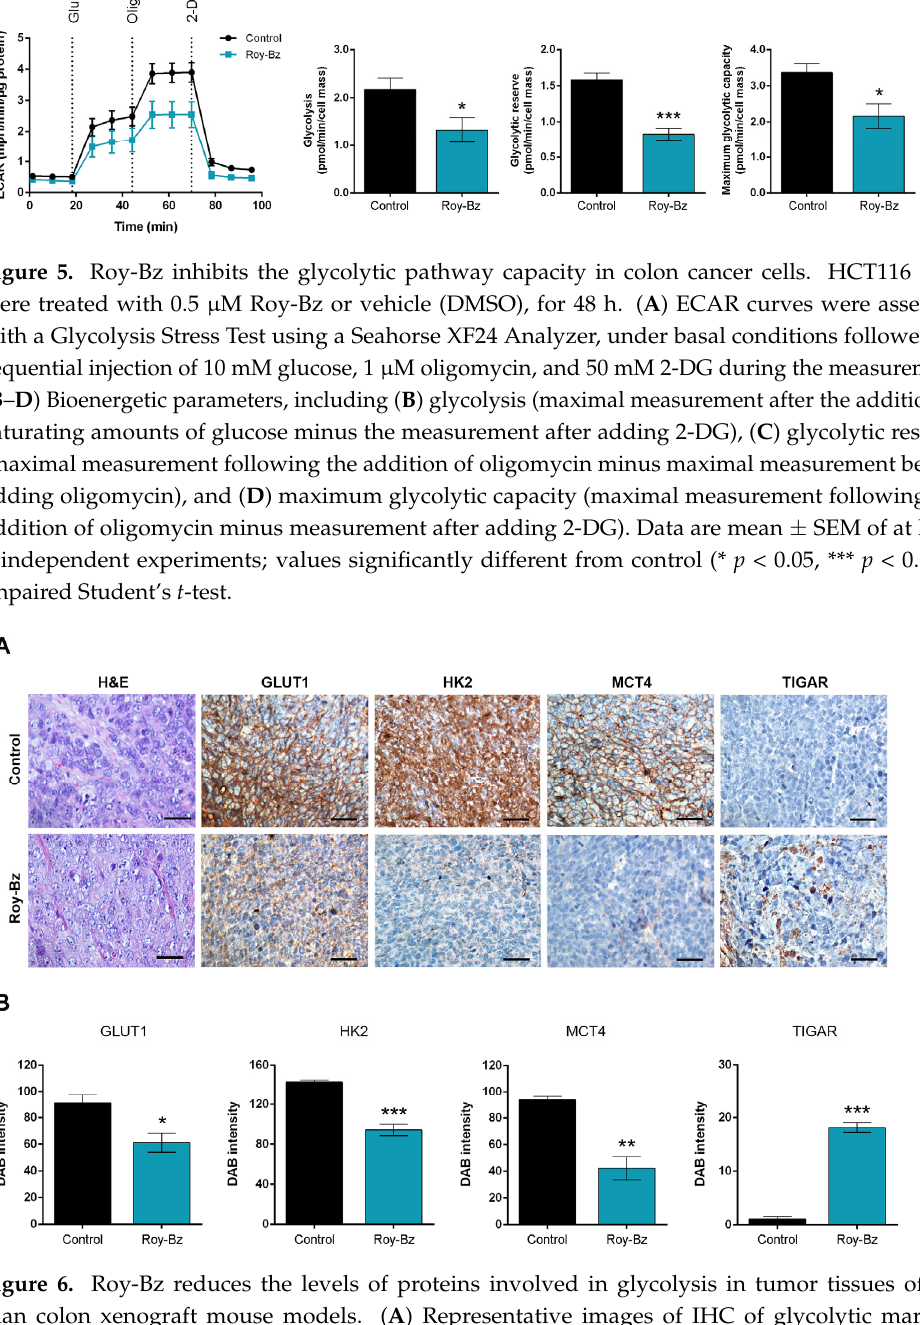
6 of 14 Figure 4. Roy-Bz inhibits cellular respiration in tumor tissues of human colon xenograft mouse mod- els. ( A ) Representative images of IHC of mitochondrial markers (COX4 and TOM20) detected in tumor tissues of HCT116 xenografts treated with 10 mg/kg Roy-Bz or vehicle (control) and collected at the end of the treatment (scale bar =5 μ m; magnification = ×200; hematoxylin and eosin (H&E)). ( B ) Quantification of IHC staining of HCT116 xenograft tumor tissues was assessed by evaluation of DAB intensity. Data are mean ± SEM; values significantly different from control (*** p < 0.001, **** p < 0.0001), unpaired Student’s t -test. 2.2. Roy-Bz Inhibits Glycolysis of Colon Cancer Cells The ability of Roy-Bz to affect the glycolytic rate of HCT116 cells was explored by measuring the extracellular acidification rate (ECAR) by Seahorse analysis. For that, key glycolytic parameters were determined through sequential compound applications dur- ing the experiment, including glucose (glycolysis substrate), oligomycin (ATP synthase inhibitor; inhibits mitochondrial ATP production and shifts the energy metabolism to gly- colysis), and 2-deoxyglucose (2-DG; glucose analogue that inhibits glycolysis through competitive binding to hexokinase 2 (HK2)). The results showed that Roy-Bz decreased ECAR after glucose injection (Figure 5A), thus indicating a lower overall glycolytic activ- ity of Roy-Bz-treated cells, when compared to control. Although Roy-Bz did not interfere with the basal levels of extracellular acidification of cells (Figure 5A), it significantly re-